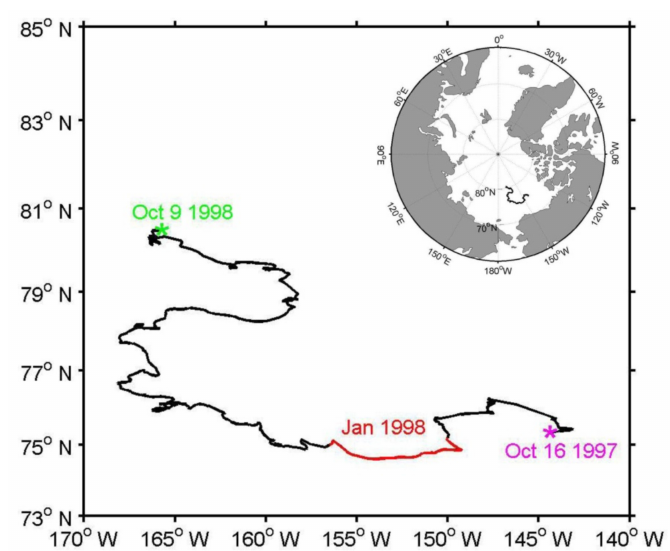
Figure 1. The track of the Surface Heat Balance of the Arctic (SHEBA) camp. The pink (green) asterisk denotes the starting (end) location. The red line indicates the track during January